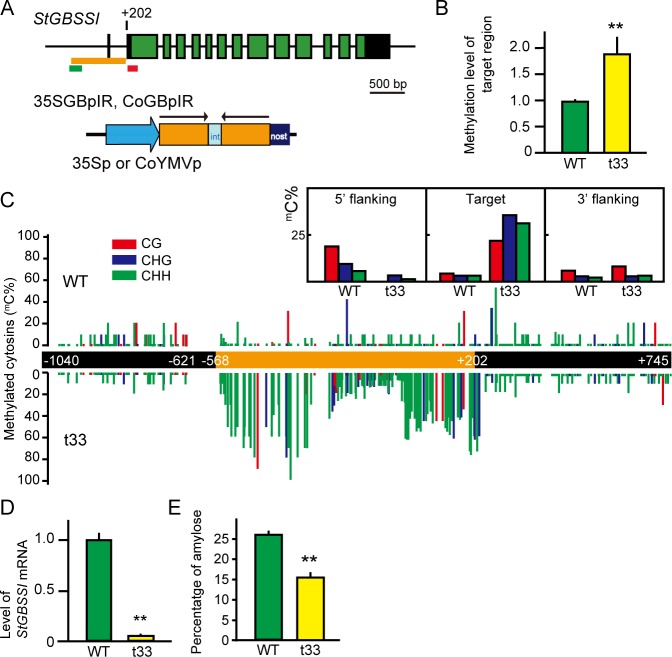
TGS induction of the endogenous gene StGBSSI in 35SGBpIR transgenic potato.(A) Schematic diagram of the GBSSI 5'-flanking region in potato ‘Waseshiro’. Black boxes are untranslated regions, and green boxes are exons. Orange bar shows the target region. Green and red bars indicate regions used for methylation level and transcription level analyses, respectively. The construct of 35SGBpIR and CoGBpIR is drawn schematically. (B) Methylation level of the target region in the potato leaves of in vitro sub-culturing shoots. WT: wild type, t33: 35SGBpIR line 33. Asterisks show statistically significant (**; P<0.01 Student's t test) differences relative to 35SGFP. Means and SD of 3 biological replicates are shown. (C) DNA methylation status in the target (orange) and its flanking regions (black) of GBSSI. The leaves were subjected to bisulphite sequencing. The percentages of methylation at individual cytosines are shown. Upper and lower are WT and t33 results, respectively. 5'-flanking region from -621 to -568 couldn't analyze due to lack of appropriate primer sets. The methylation rates of cytosines with different sequence backgrounds are shown in the inset box. (D) Down-regulation of the GBSSI transcript level in t33. (E) Percentage of amylose in the starch of WT and t33 tubers (n = 5) which were grown in a glasshouse.